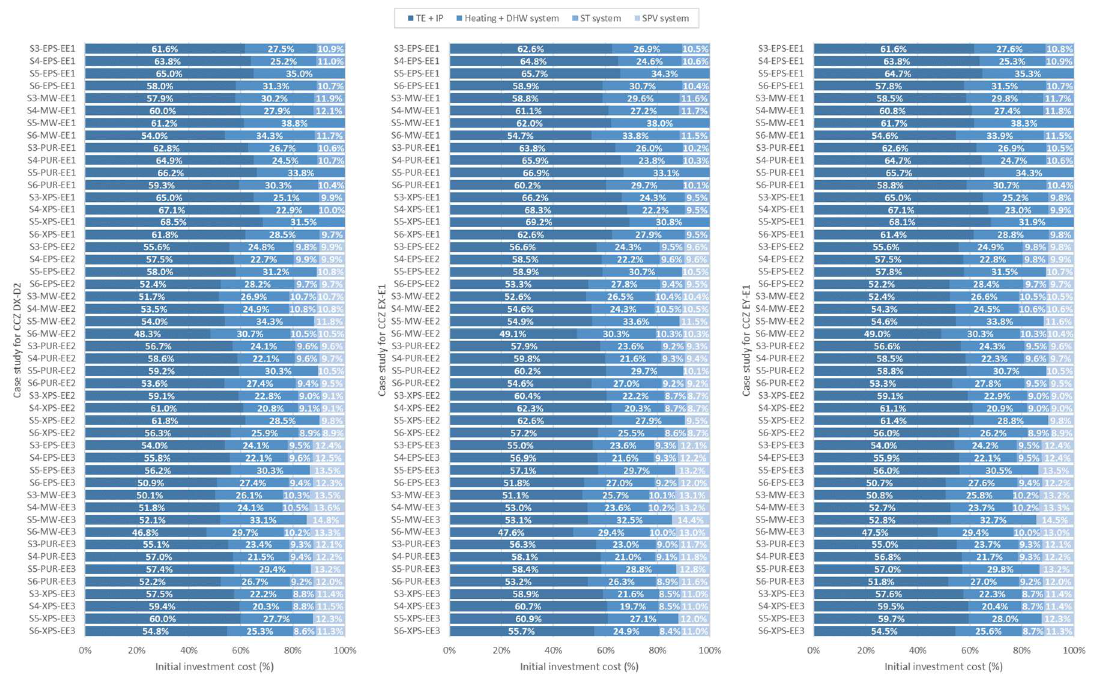
Figure 4. Initial investment cost breakdown by type of energy renovation measure, in %, for each case study in each CCZ. Note: TE + IP is thermal envelope and interior partitions; ST is solar thermal; SPV is solar photovoltaic.